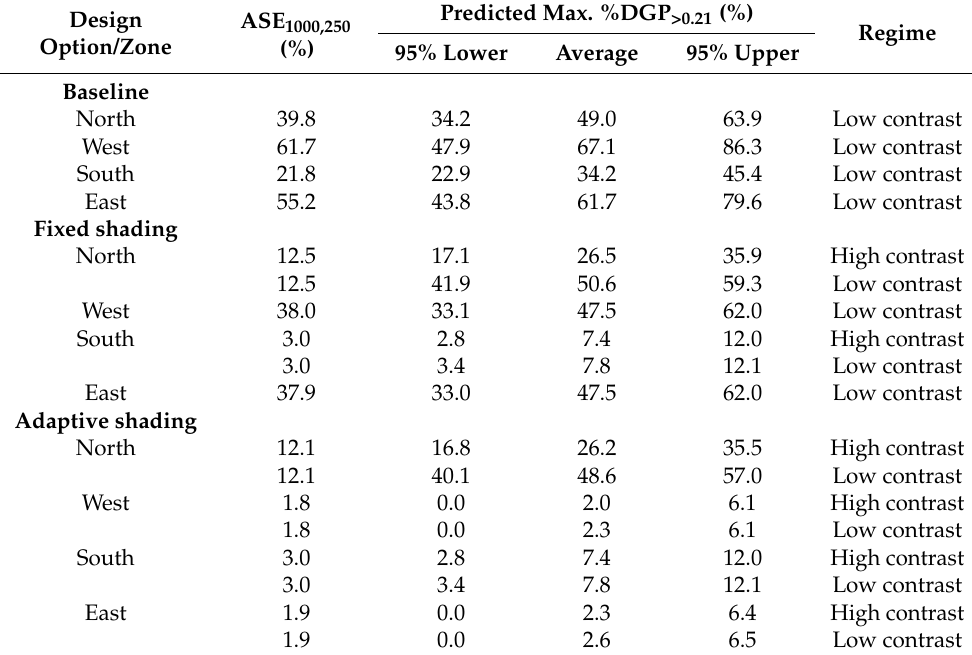
Table 5. Predicted maximum %DGP >0.21 values for the simulation results in the baseline, fixed shading, and adaptive shading design options.